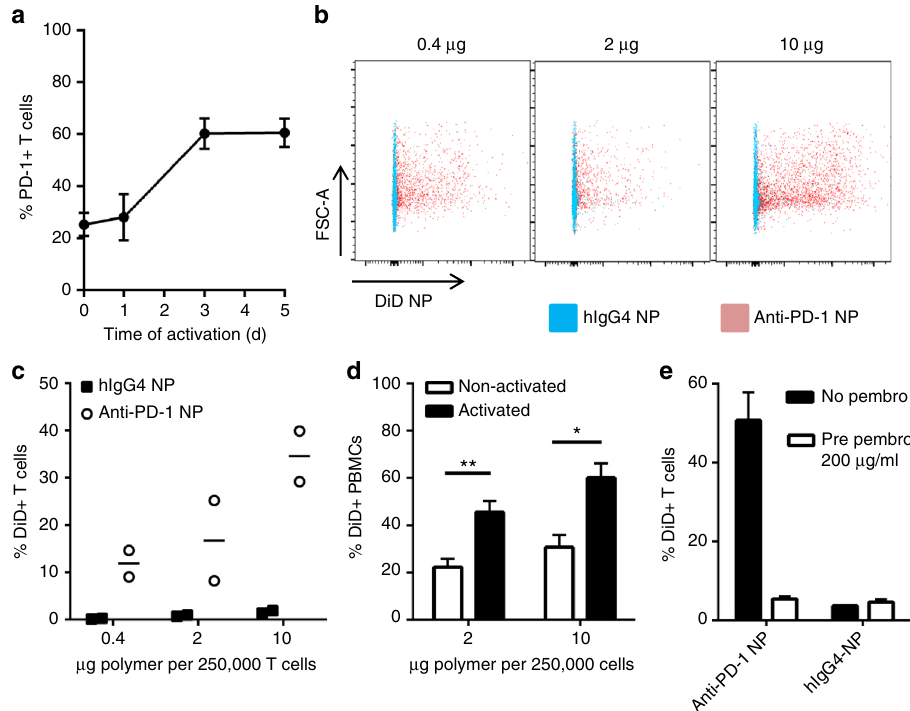
Fig. 4 PD-1-targeting nanoparticles bind to activated human T cells. a PD-1 expression on human CD3 + T cells following activation with anti-CD3/CD28 complex, n = 4 independent donors, mean ± s.e.m. b Dose-dependent binding of PD-1-targeting nanoparticles to 250,000 activated human T cells. c Quanti fi cation of T cells that were bound by DiD-loaded, PD-1-targeting nanoparticles; graph shows results of two donors and is representative for at least two independent experiments. d Dose-dependent binding of PD-1-targeting nanoparticles to activated and non-activated peripheral blood mononuclear cells (PBMCs), n = 4, mean ± s.e.m. e Pre-incubation of activated human T cells with free pembrolizumab (pre pembro) for 30 min blocks binding of